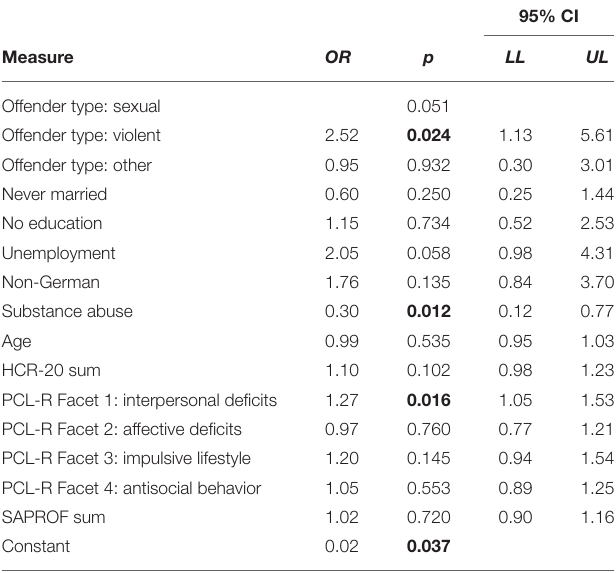
TABLE 4 | Pearson χ 2-test of completion status by risk and protection levels. Completers Dropouts